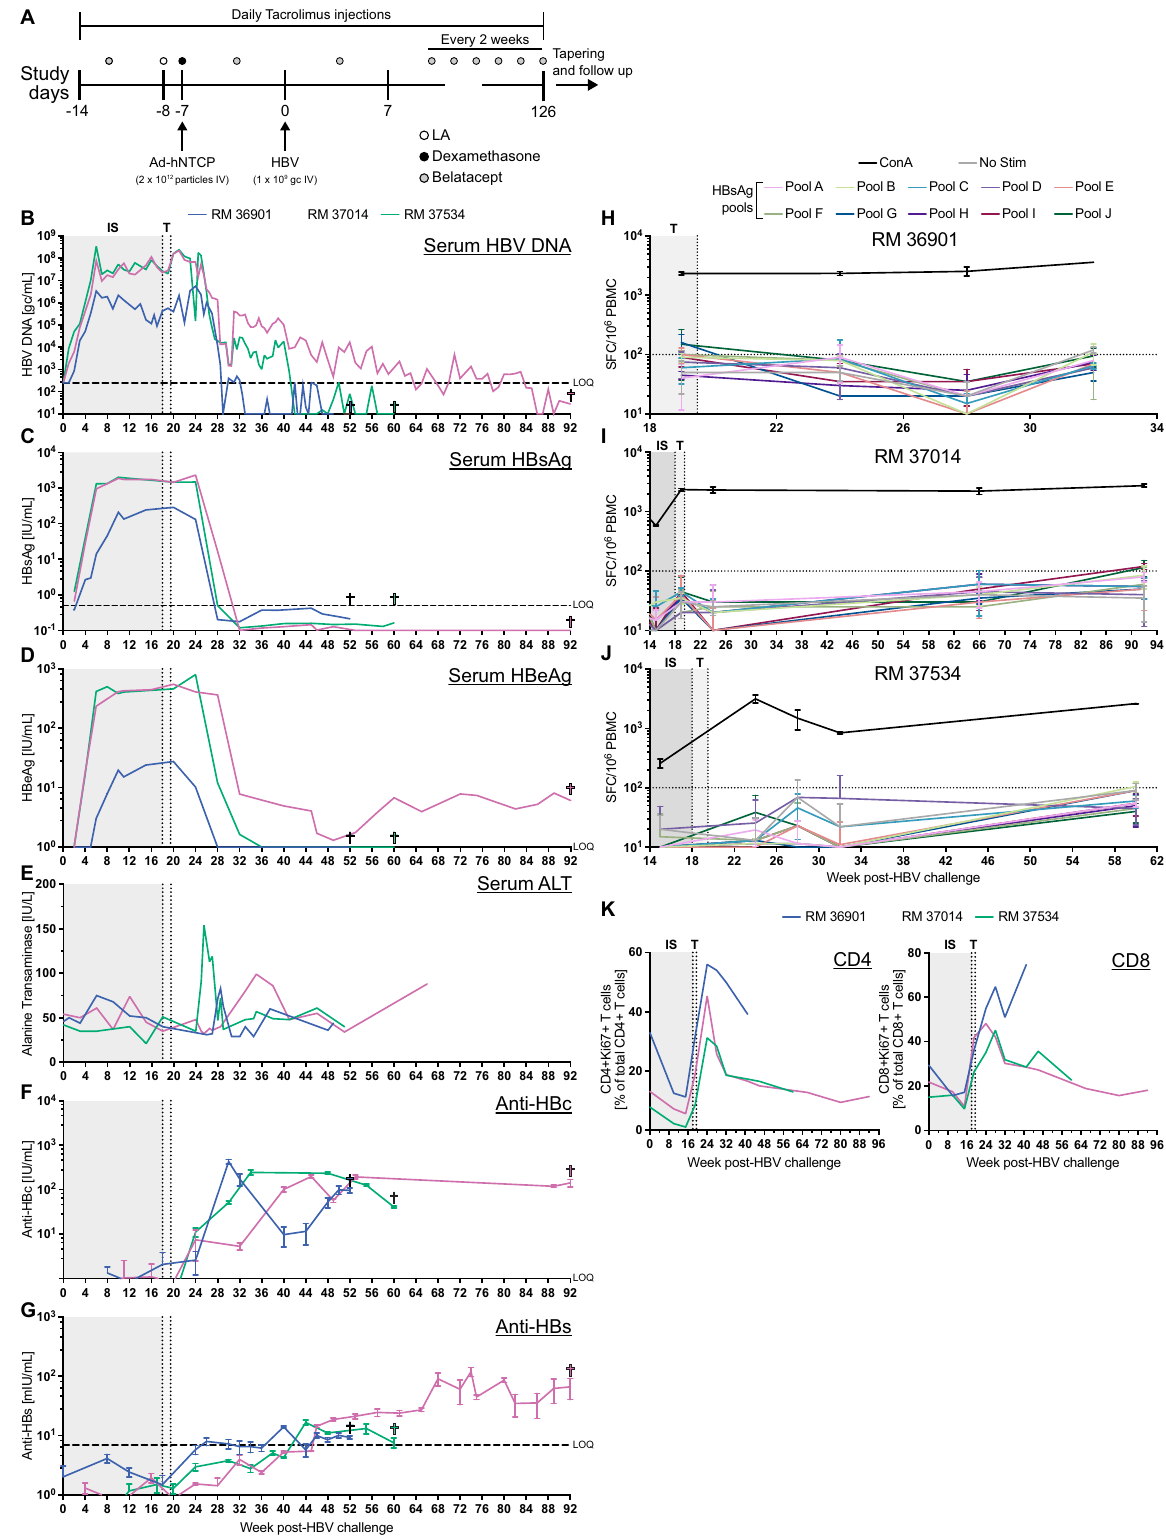
Fig. 3 Sustained HBV replication in RM on immunosuppression. A Timeline for HBV infection and immunosuppression of RM. B HBV DNA levels in serum during and postremoval of immunosuppression. C HBsAg levels in serum. D HBeAg levels in serum. E ALT levels in serum. F Anti-HBc IgG quanti fi cation in serum. G Anti-HBs IgG quanti fi cation in serum. H – J Longitudinal measurements of anti-HBsAg T cells by IFN γ ELISpot. K Frequency of Ki67-expressing CD4 + and CD8 + T cells in the PBMC. SFC = spot forming cell. Data are presented as mean values + / − SD. Source data are provided as a Source Data fi